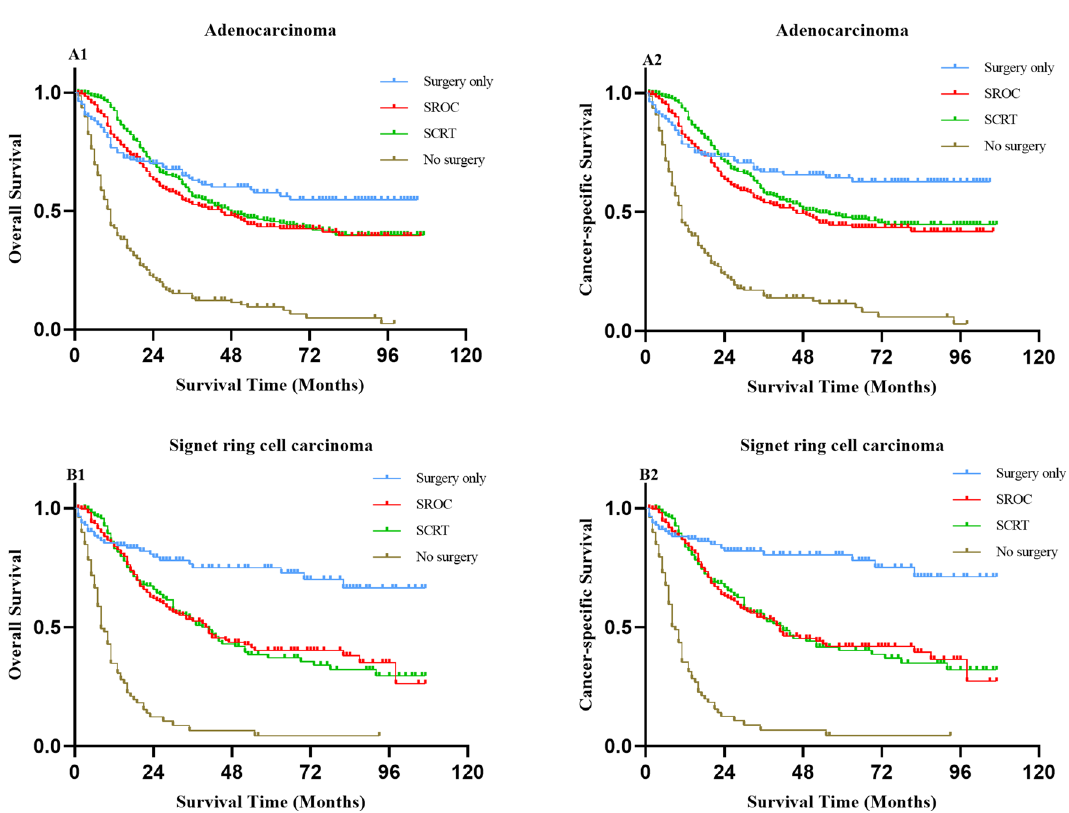
Figure 3. Kaplan–Meier survival curves for overall survival ( A1 , B1 ) and cancer-specific survival ( A2 , B2 ) in patients with gastric adenocarcinoma and SRCC undergoing different treatments respectively. SROC, surgery plus radiotherapy or chemotherapy; SCRT, surgery plus chemoradiotherapy; SRCC, signet ring cell